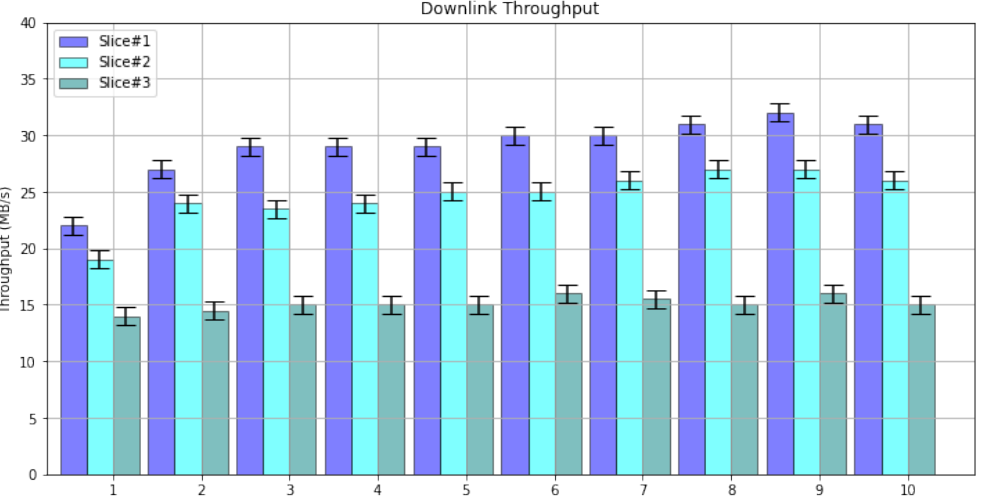
Figure 11. Iperf downlink throughput for three slices.